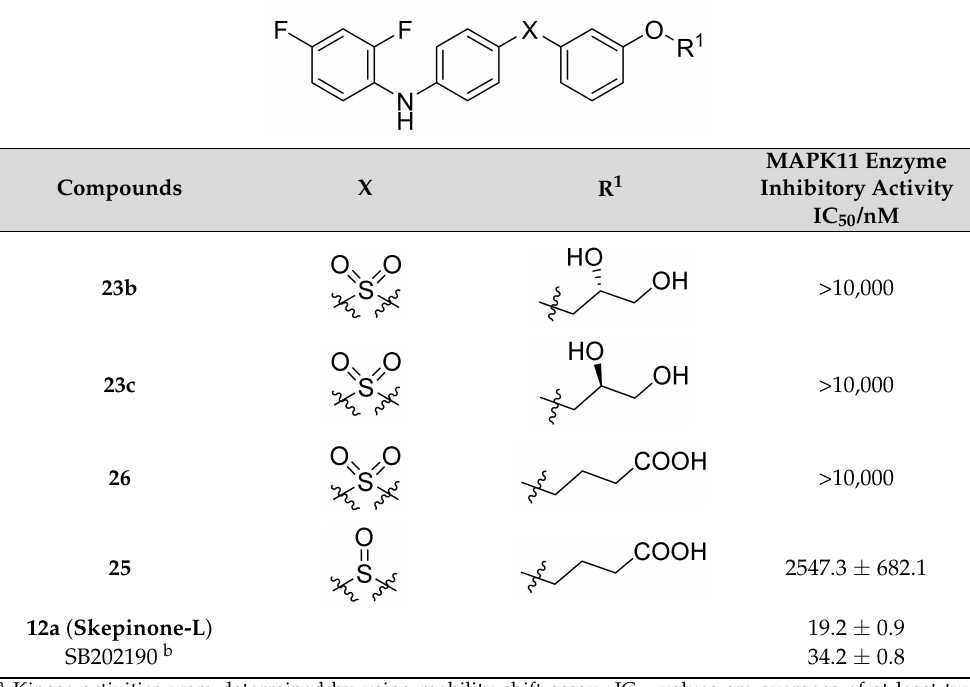
Table 2. Inhibitory activities of diarylsulfone and sulfoxide derivatives against MAPK11 enzyme a